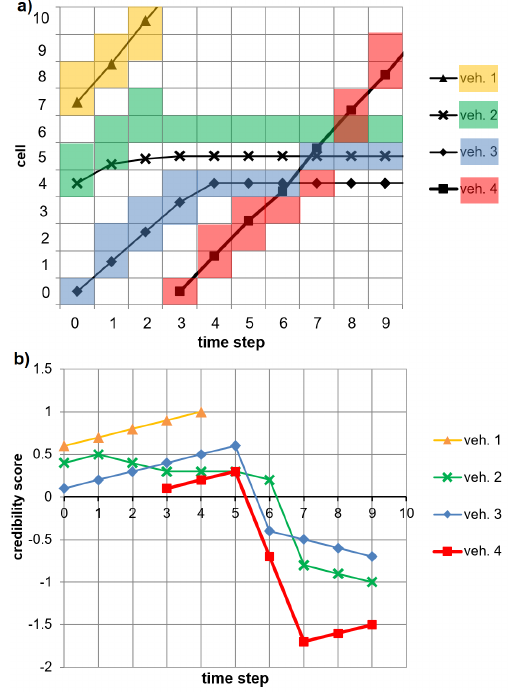
Figure 5. Vehicles approaching green traffic light: ( a ) time-space trajectories ( b ) credibility